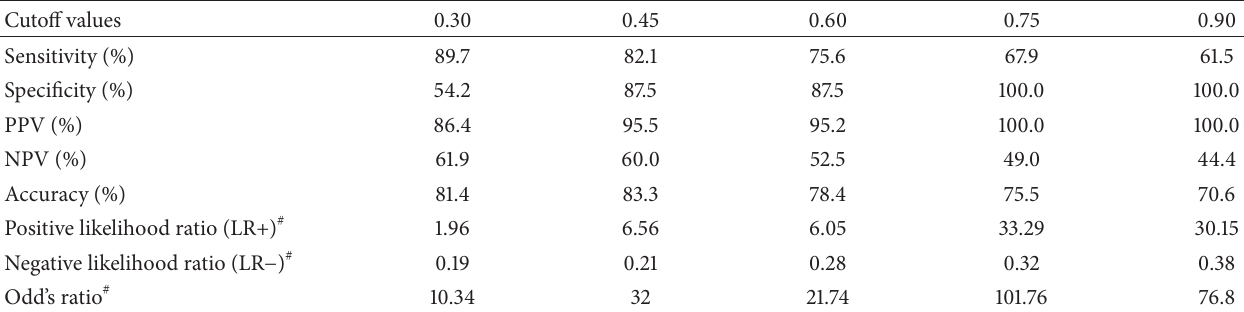
Table 4: Diagnostic test characteristics at various cutoff values for UPCR to predict proteinuria of 300 mg/day or more.